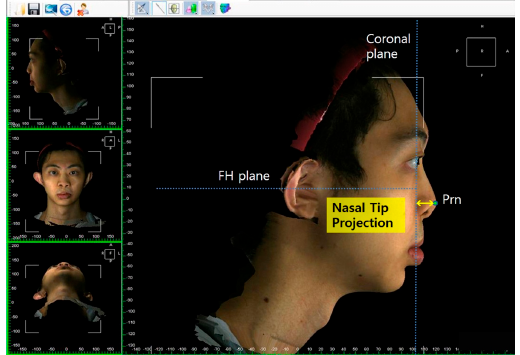
Figure 4. Representation of nasal tip projection.